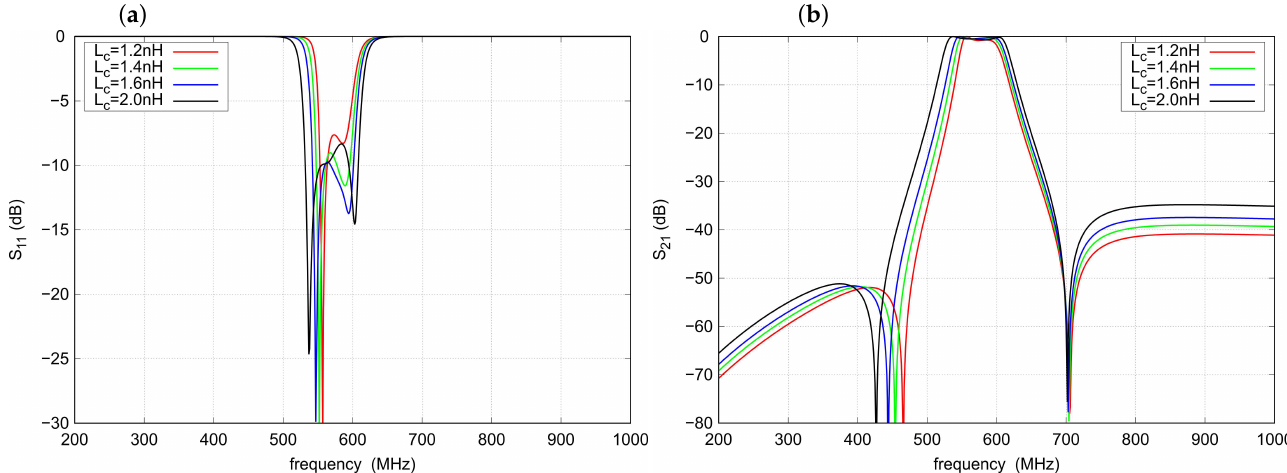
Figure 6. Influence of the L c inductance on the filter response: ( a ) s 11 parameter, ( b ) s 21